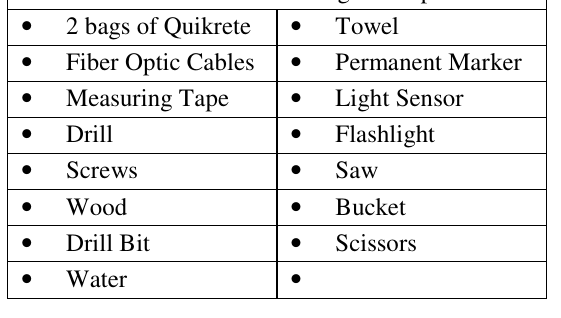
Table 2: Materials used during the Experiment